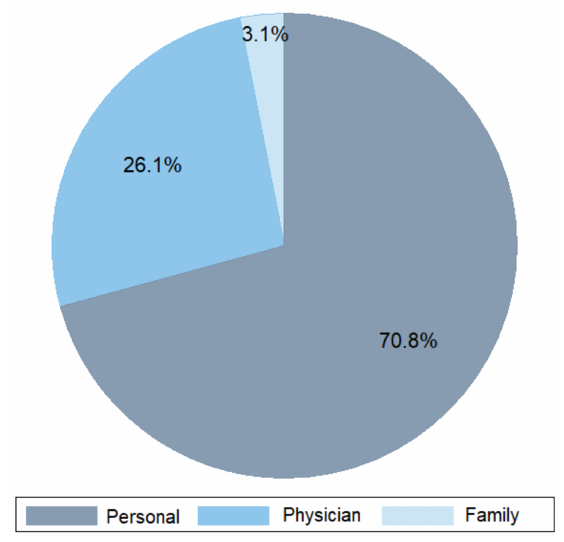
Figure 2. Initiators of the 260 phage therapy requests. Table 1. Demographics and microbiology of patients requesting phage therapy at the Queen Astrid military hospital ( n =